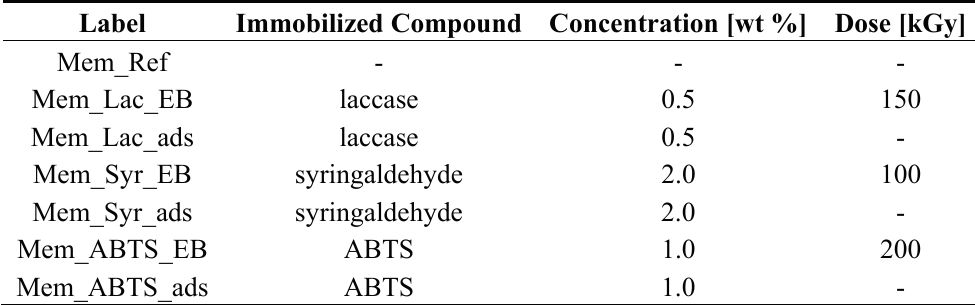
Table 4. Membrane modification